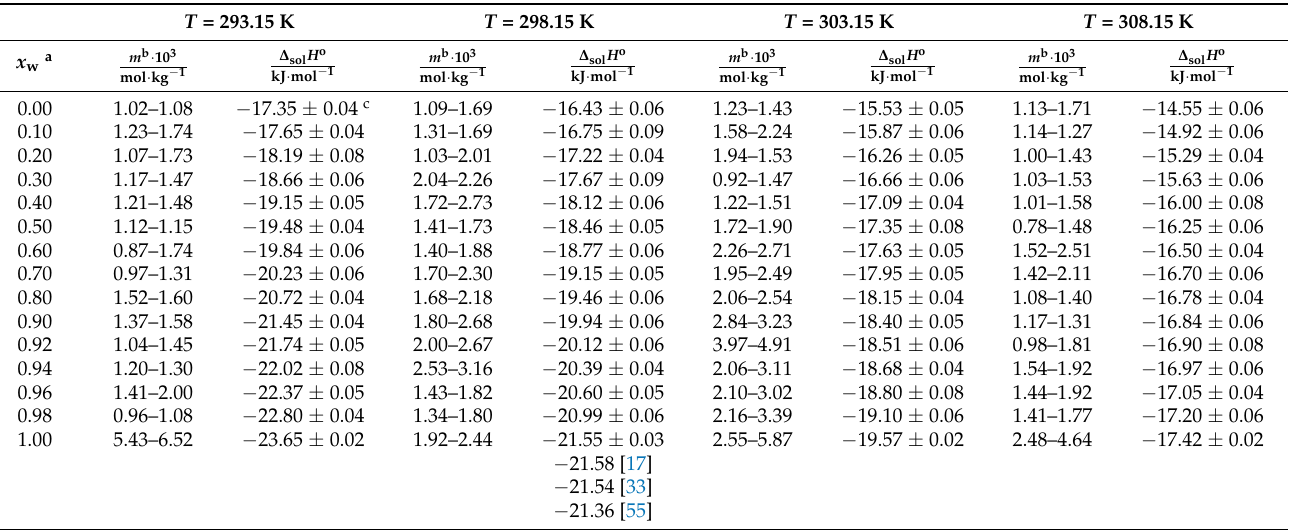
Table 6. Standard molar enthalpy of solution ( ∆ sol H o ) and molality ( m ) of 18C6 in the F + W mixtures at T = (293.15, 298.15, 303.15, 308.15)